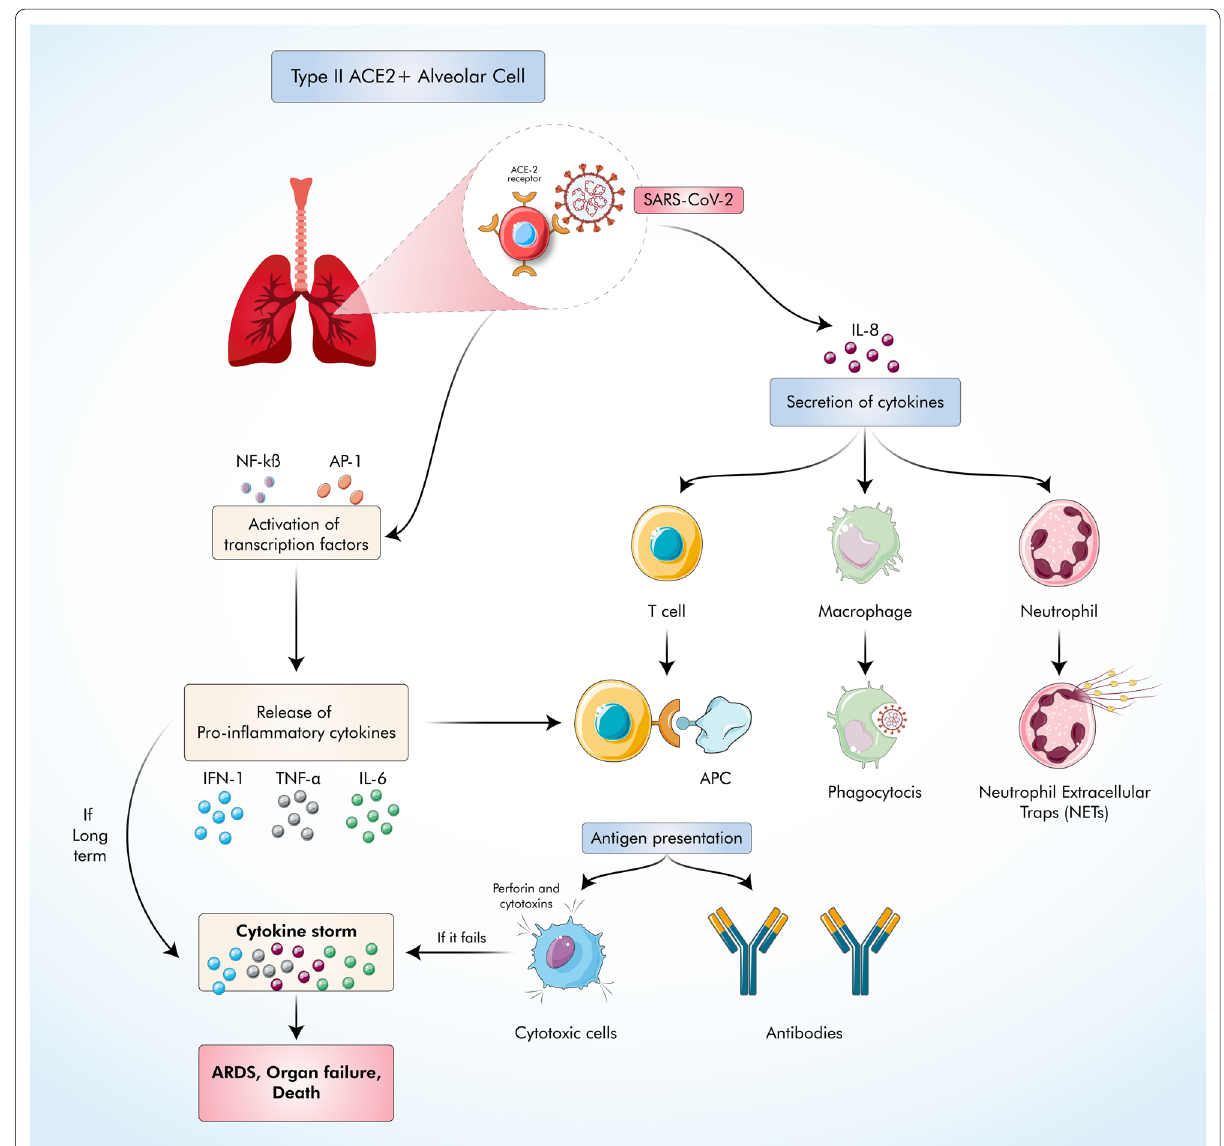
Fig. 1 SARS-CoV-2 infects primarily alveolar cells through the ACE2 receptor. The immune system responds to the virus by activating different transcription factors that release pro-inflammatory cytokines that trigger the accumulation of immune cells leading to antigen presentation. Additionally, secretion of specific cytokines such as IL-8 attracts neutrophils and macrophages to the site of infection alongside T lymphocytes. While neutrophils kill by oxidative burst and NETs with macrophages inducing phagocytosis, CD4 anti-SARS-CoV-2 and CD8 T cells kill infected cells through the release of perforins and cytotoxins. If CD8 + presence of inflammatory cytokines over the long term, cytokine storm occurs, leading to disease progression and complications such as ARDS, organ failure, and